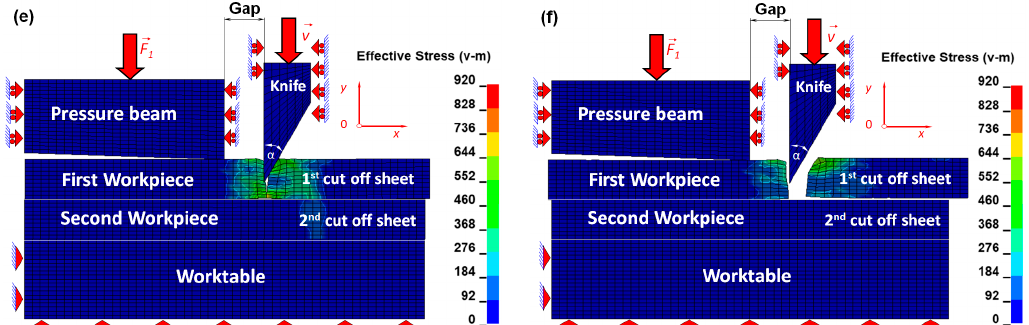
Figure 4. Huber–Mises stresses in the first sheet being cut for the following time instances: ( a ) t = 3 s, ( b ) t = 3.5 s, ( c ) t = 4.5 s, ( d ) t = 5 s, ( e ) t = 5.55 s, ( f ) t = 5.56 s. The visualisation of stresses for the next